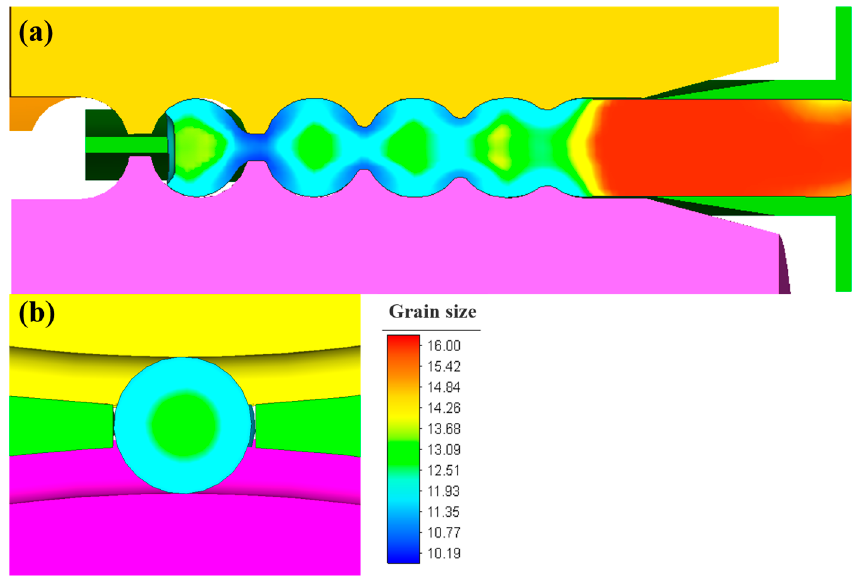
Figure 11. Grain size distribution of steel balls during the skew rolling process in ( a ) the longitudinal section and ( b ) the transverse section.